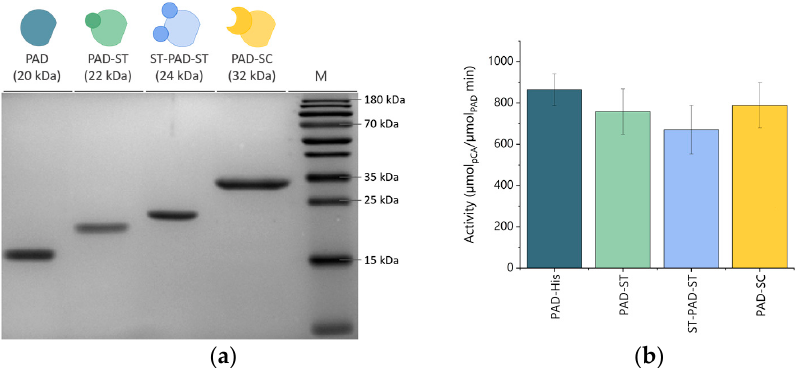
Figure 2. Variants of phenolic acid decarboxylase (PAD) from Enterobacter sp. containing either one or two SpyTag (ST) or one SpyCatcher (SC) were expressed in Escherichia coli , purified and tested for their activity towards p ‐ coumaric acid. Note that all proteins carry a C ‐ terminal 6× His ‐ Tag. ( a ) Denaturing 16% SDS ‐ PAGE analysis of the purified PAD constructs. The PAD variants used here are homodimers in their native form. Lane 1: PAD (20 kDa), Lane 2: PAD ‐ ST (22 kDa); Lane 3: ST ‐ PAD ‐